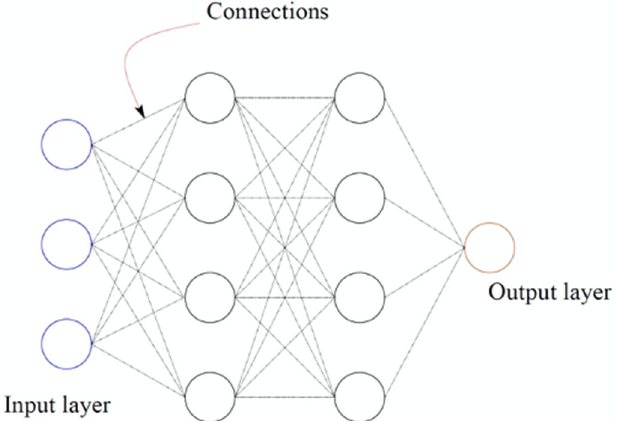
Figure 1. A typical Feedforward neural network with three input variables, one output variable and 4 × 2 hidden layers.